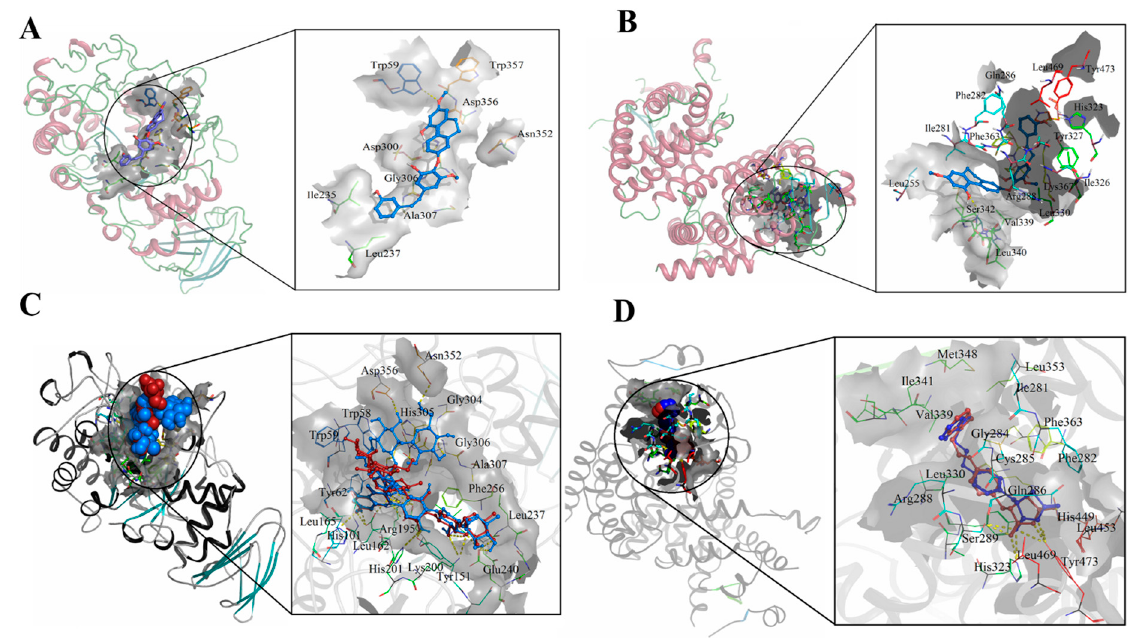
Figure 2. ( A ) Docking image Amylase—shancilin, ( B ) Docking image PPAR- γ —shancilin, ( C ) Redocked image amylase— Montbretin, ( D ) Redocked image PPAR- γ —rosiglitazone.